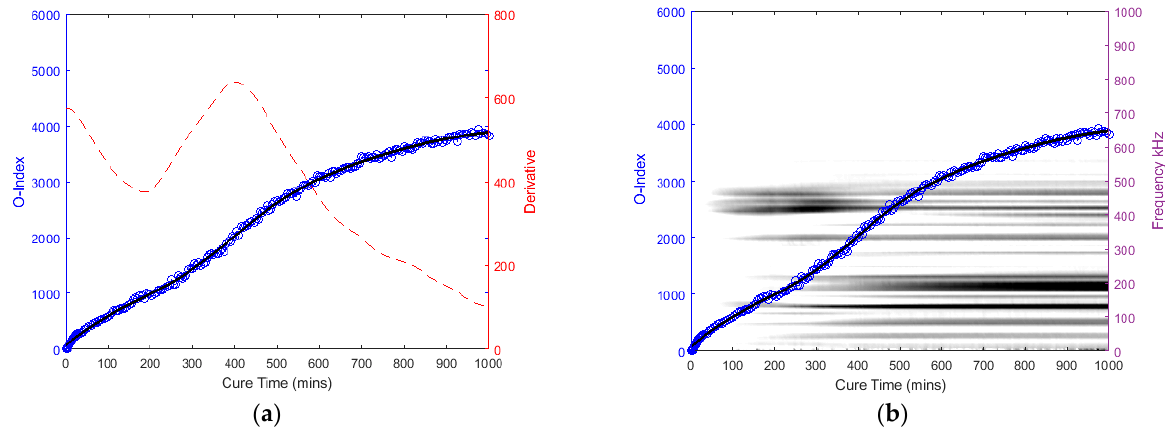
Figure 15. Oval specimen (Far): O-Index with ( a ) its time derivative and ( b ) its change in frequenc y.